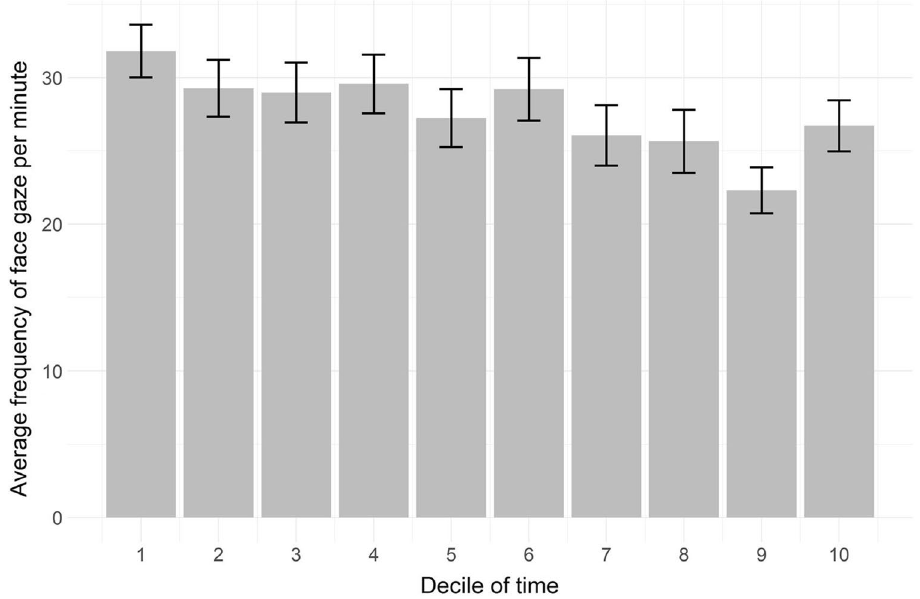
Figure 2. Development of the physicians’ face gaze frequency per minute throughout the consultations per decile of time.